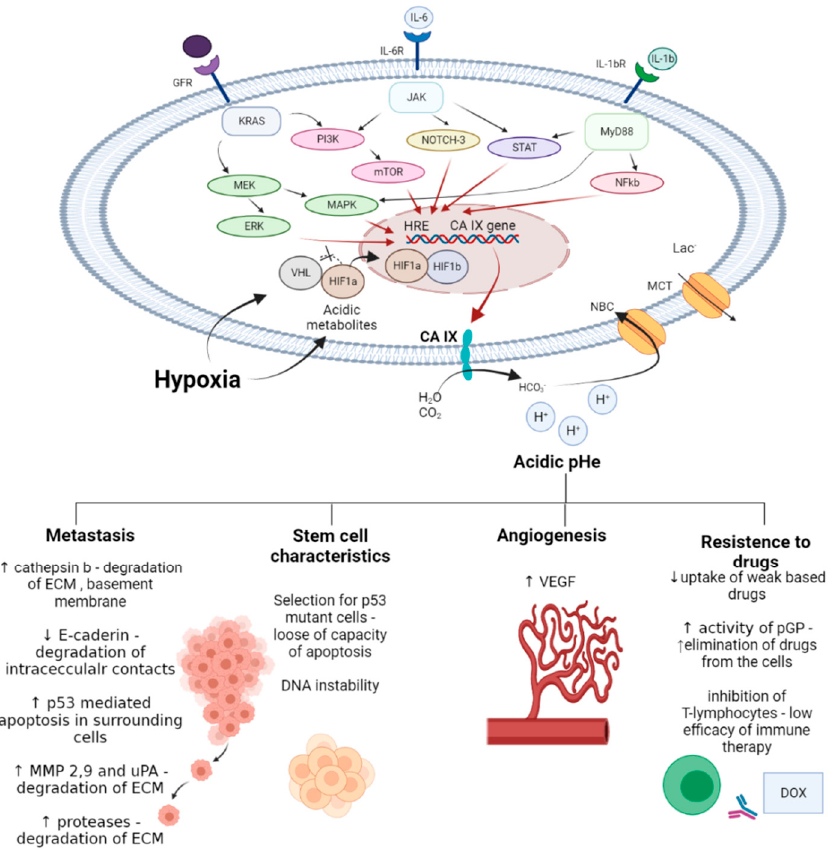
Figure 20. General considerations on the mechanisms of anticancer drug potentiation by CA IX inhibition in cancer